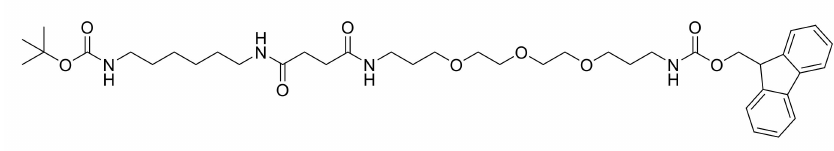
Figure 9. Chemical structure of 3